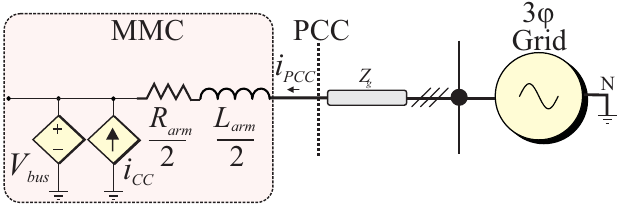
Figure 3. MMC per phase average circuit.